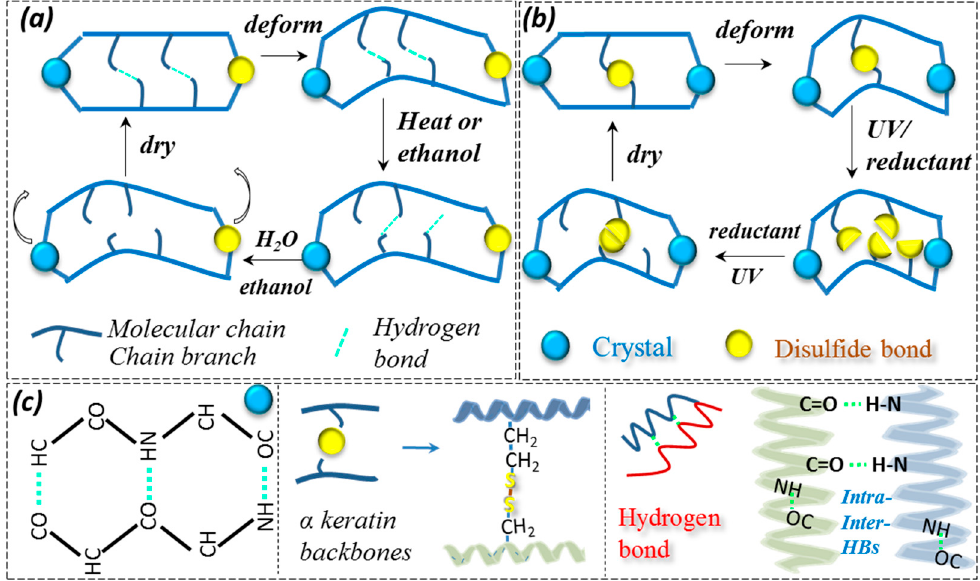
Figure 10. The mechanism illustration of coupled stimuli responsive SME of α -keratin hair fiber: ( a ) crystal and disulfide bonds acting as netpoints and hydrogen bonds acting as switches for the SME of hair fiber under the coupled stimuli of heat-water and ethanol-water, separately; ( b ) crystal and disulfide bonds acting as netpoints and switches for the SME of hair fiber under the stimuli of UV (reductant) and reductant (UV), reversibly; ( c ) symbols of crystal made of dense hydrogen bonds, disulfide bonds between two keratin backbones, and hydrogen bonds at intra-macromolecules and between inter-molecules chains.